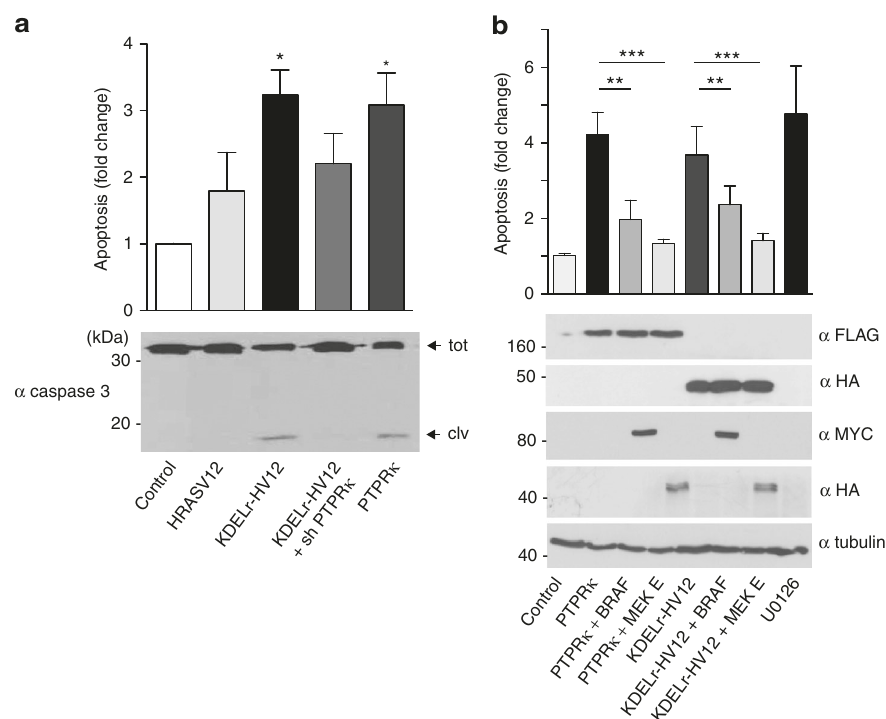
Fig. 7 Induction of apoptosis by oncogenic RAS at the GC. a GC RAS-induced apoptosis dependence on PTPR κ . Apoptosis, determined by annexin V levels (bar chart) and by western blotting for activated Caspase-3, in MCF-7 cells transfected with the indicated constructs (1 μ g) and siRNAs (10 nM). Arrows show total (tot) and cleaved (clv) caspase-3. b GC RAS- and PTPR κ -induced apoptosis require ERK downregulation, as revealed in MCF-7 cells transfected with the indicated constructs. a , b Data show average ± SEM from three independent experiments * p < 0.05; ** p < 0.001; *** p < 0.005 by Student's t